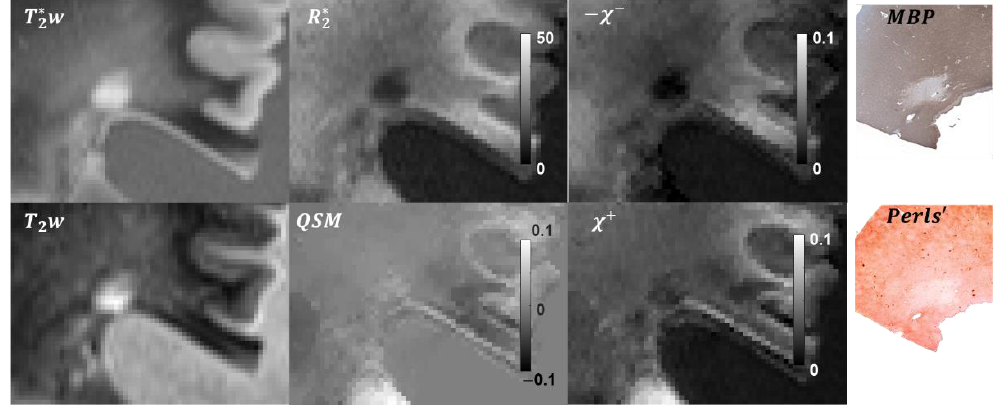
Figure 2. Example of the R ∗ -based separation of magnetic sources in a chronic silent lesion. The 2 lesion appears to be weakly paramagnetic in the susceptibility map, with the Perls’ and MBP staining suggesting almost complete loss of myelin and partial loss of iron within the lesion ROI. These findings were similarly reflected in the estimated χ + and χ −